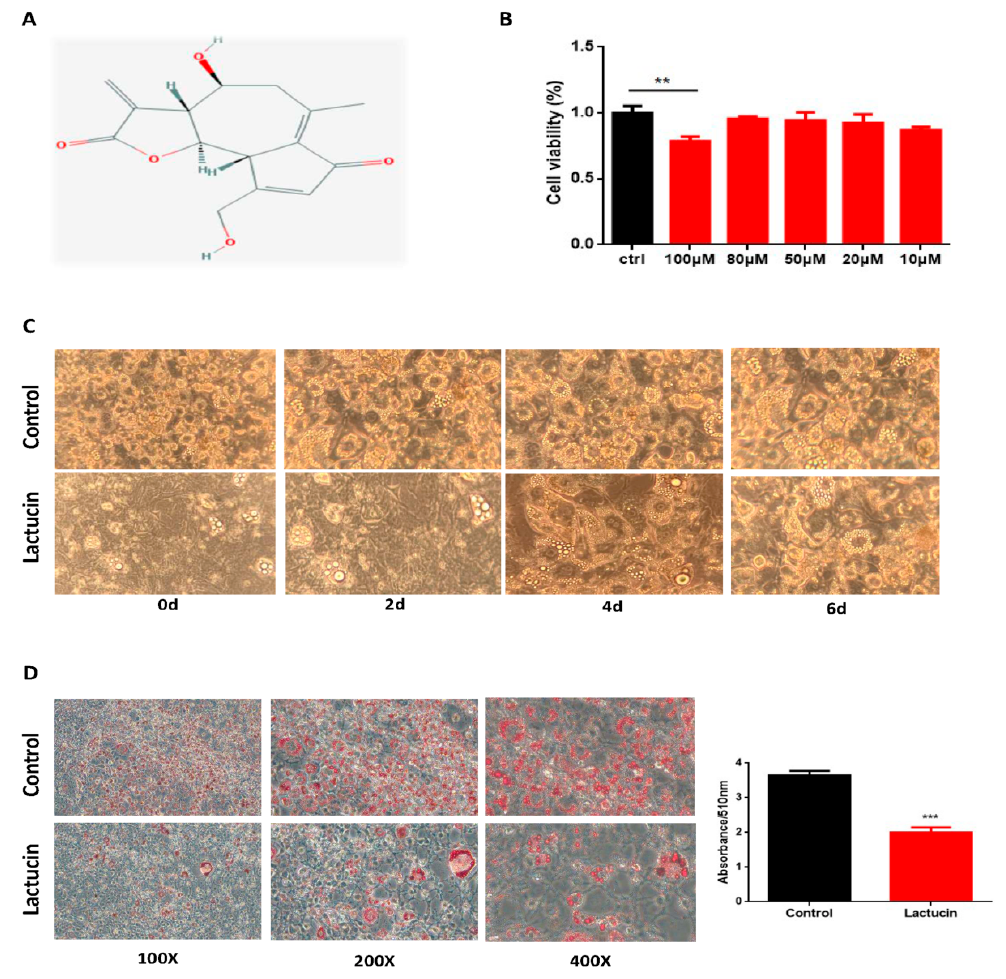
Figure 2. Inhibition of lactucin on lipid accumulation in 3T3-L1 adipocytes. ( A ) The molecular formula of lactucin. ( B ) 3T3-L1 preadipocytes were treated with the indicated concentrations of lactucin for 48 h. Cell proliferation was then determined by the CCK-8 assay ( n = 5). 3T3-L1 preadipocytes were induced to differentiate with the standard regimen (IBMX, dexamethasone, and insulin; MDI) and 20 μ M lactucin was added 0–6, 2–6, 4–6 and 6–8 days of adipogenesis. ( C ) Morphological observation and ( D ) Oil Red O staining of 3T3-L1 adipocytes photographed using a microscope (×100). Lipid droplets were stained in red. And absorbance of extracted ORO accumulated in lipid droplets of 3T3-L1 adipocytes was measured spectrophotometrically at 510 nm. Values are mean ± S.E.M. ** p < 0.01, *** p < 0.001. 3.3. Lactucin Treatment Inhibits Adipogenesis of 3T3-L1 Cells by Downregulation of TG Synthesis Next, we try to detect whether less lipid accumulation in lactucin-treated cells was attributed to lower levels of TG synthesis. Levels of key transcription factors PPAR γ , C/EBP β , and C/EBP α ,